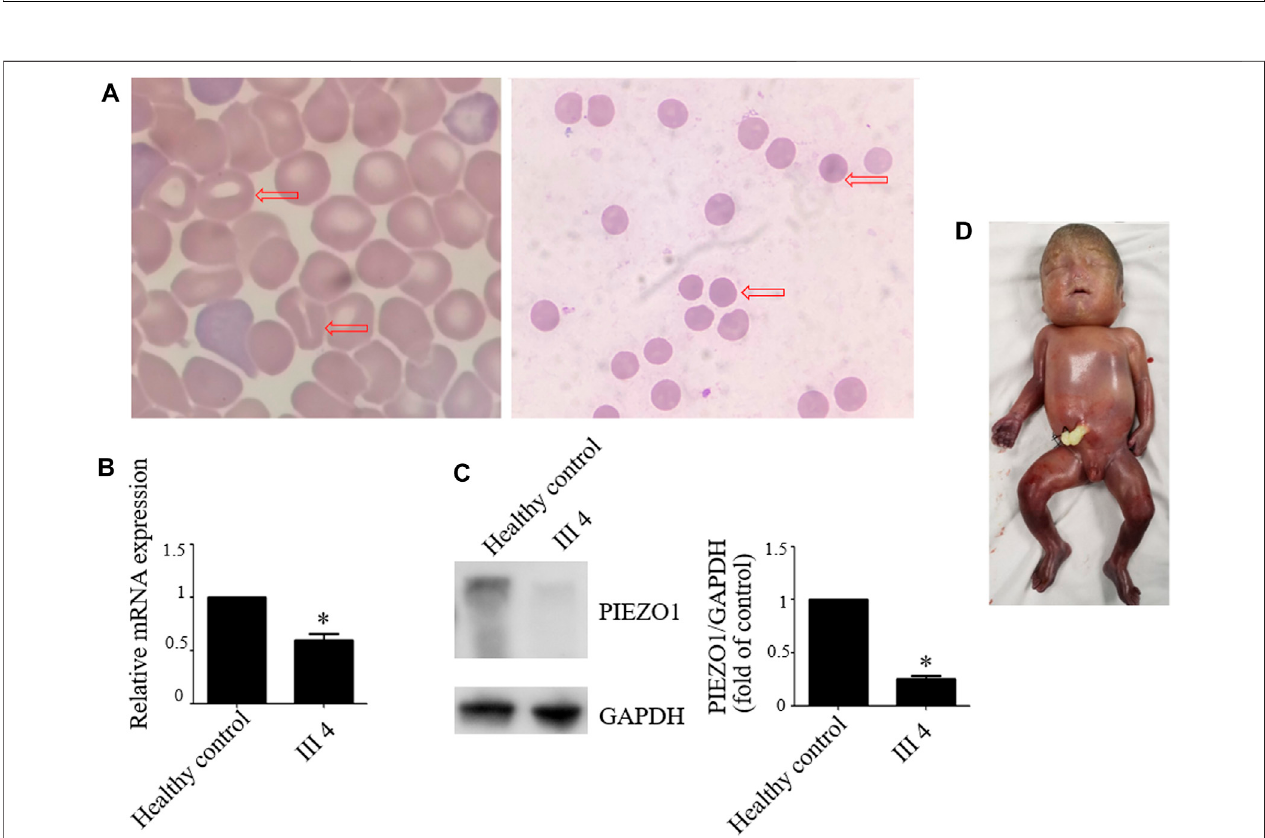
FIGURE 5 | Blood smear microscopy, PIEZO1 protein expression and the aborted fetus. (A) Blood smear microscopy showing occasional stomatocytes and spherocytes (red arrows) in III 4. (B) PIEZO1 mRNA expression is defective in III 4. (C) PIEZO1 protein expression is defective in III 4. (D) The appearance of the aborted fetus was male and manifested generalized subcutaneous edema, especially face and neck swelling.